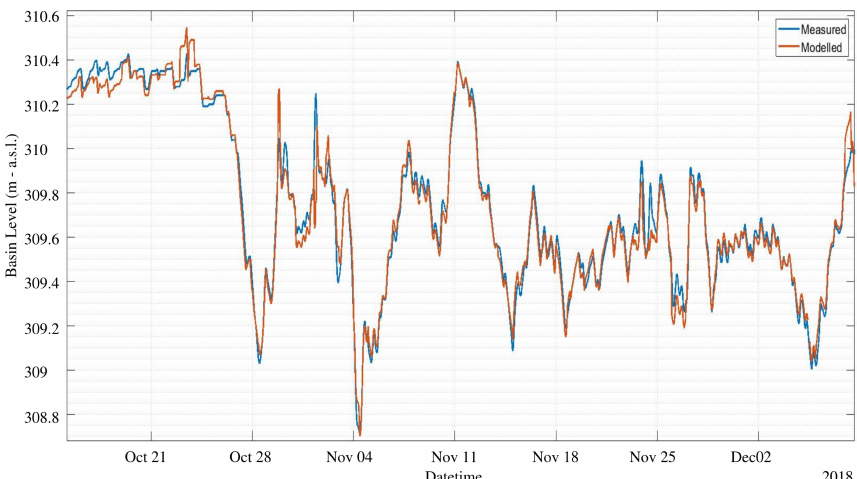
Figure 14. Predicted level during test period, comparison between NARX model and measured for h = 6 h ahead. MAE is 10 cm.